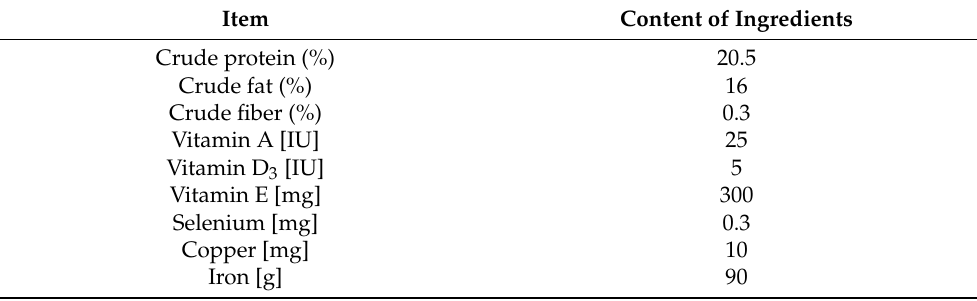
Table 2. Nutritional value of milk replacer.